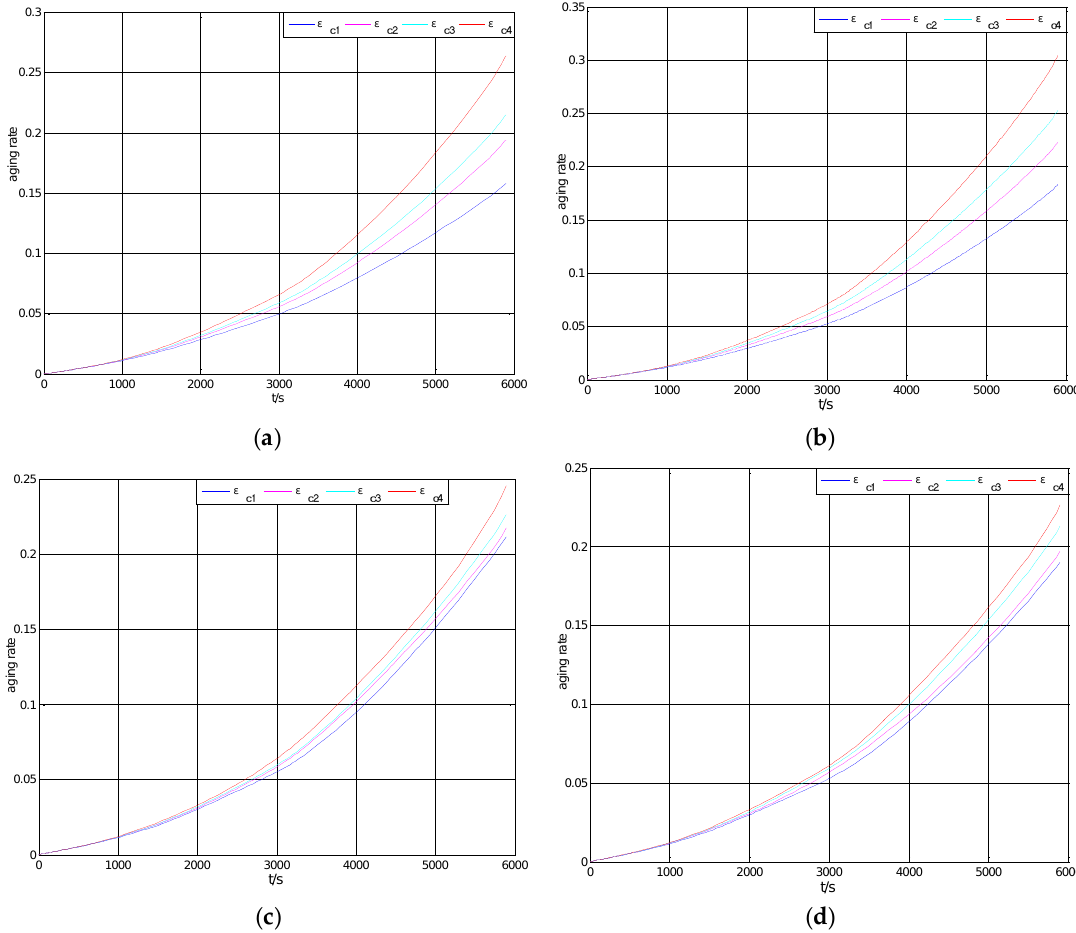
Figure 5. The results of the degradation rate under different balancing control conditions. ( a ) Non-